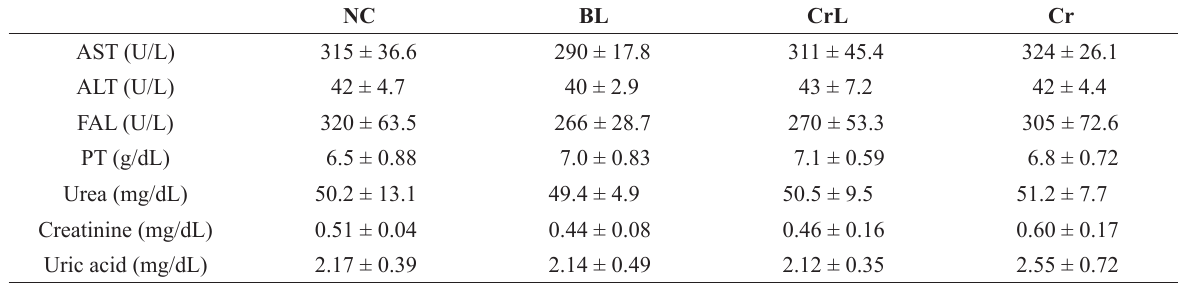
Effect of different treatments on biochemical